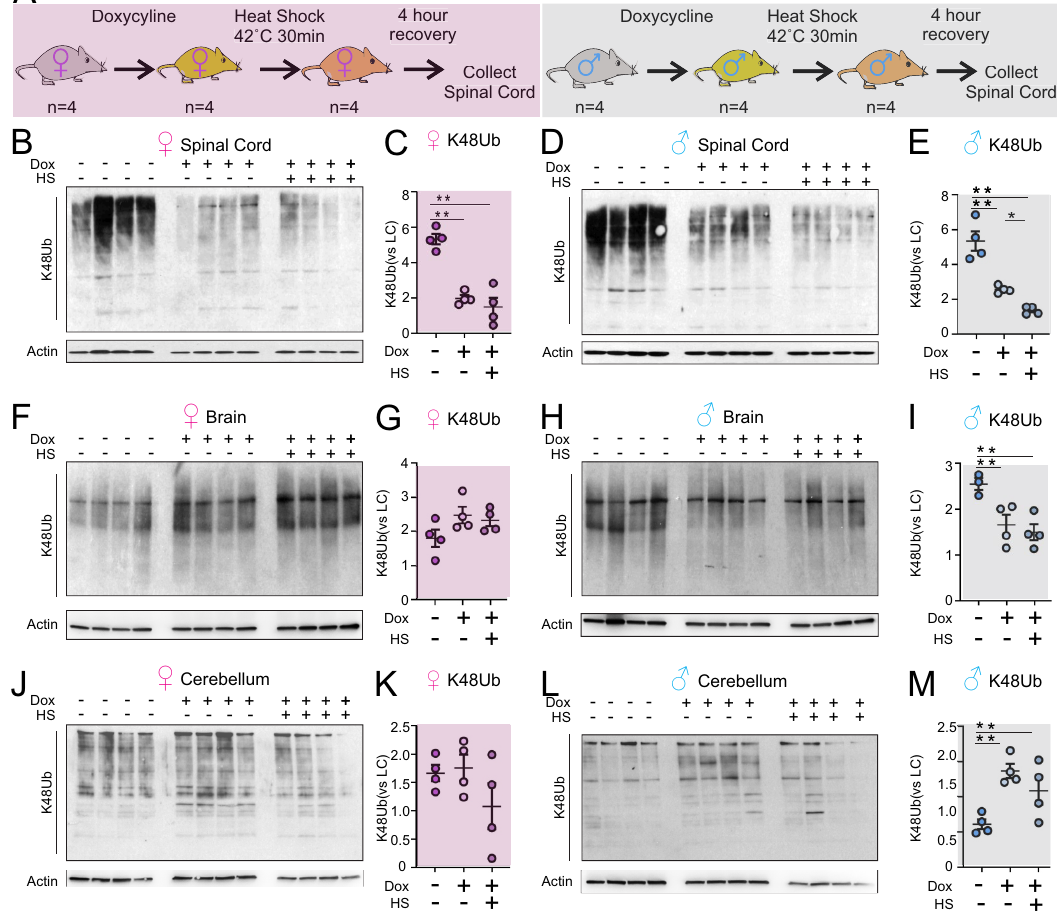
Figure 1. Doxycycline reduces accumulation of CNS K48Ub-linked proteins in a region and sex specific manner. ( A ) Schematic of the experimental design, ( B ) Western blot of K48Ub-linked proteins in the spinal cords of wild-type female mice (n = 4) that were untreated or treated with doxycycline (Dox) alone or with heat shock (HS). Loading was determined using actin. ( C ) Quantification of ( B ). ( D ) Western blot of K48Ub-linked proteins in the spinal cords of wild-type male mice (n = 4) that were untreated or treated with doxycycline (Dox) alone or with heat shock (HS). Loading was determined using actin. ( E ) Quantification of ( D ). ( F ) Western blot of K48Ub-linked proteins in the brain of wild-type female mice (n = 4) that were untreated or treated with doxycycline (Dox) alone or with heat shock (HS). Loading was determined using actin. ( G ) Quantification of ( F ). ( H ) Western blot of K48Ub-linked proteins in the brain of wild-type male mice (n = 4) that were untreated or treated with doxycycline (Dox) alone or with heat shock (HS). Loading was determined using actin. ( I ) Quantification of ( H ). ( J ) Western blot of K48Ub-linked proteins in the cerebellum of wild-type female mice (n = 4) that were untreated or treated with doxycycline (Dox) alone or with heat shock (HS). Loading was determined using actin. ( K ) Quantification of ( J ). ( L ) Western blot of K48Ub-linked proteins in the cerebellum of wild-type male mice (n = 4) that were untreated or treated with doxycycline (Dox) alone or with heat shock (HS). Loading was determined using actin. ( M ) Quantification of L. * or **, indicates p < 0.05 or p < 0.005 by student’s t-test. For western blots in all panels, samples were run on the same gel in the indicated order with an empty well between groups to facilitate visualization and none of the images were